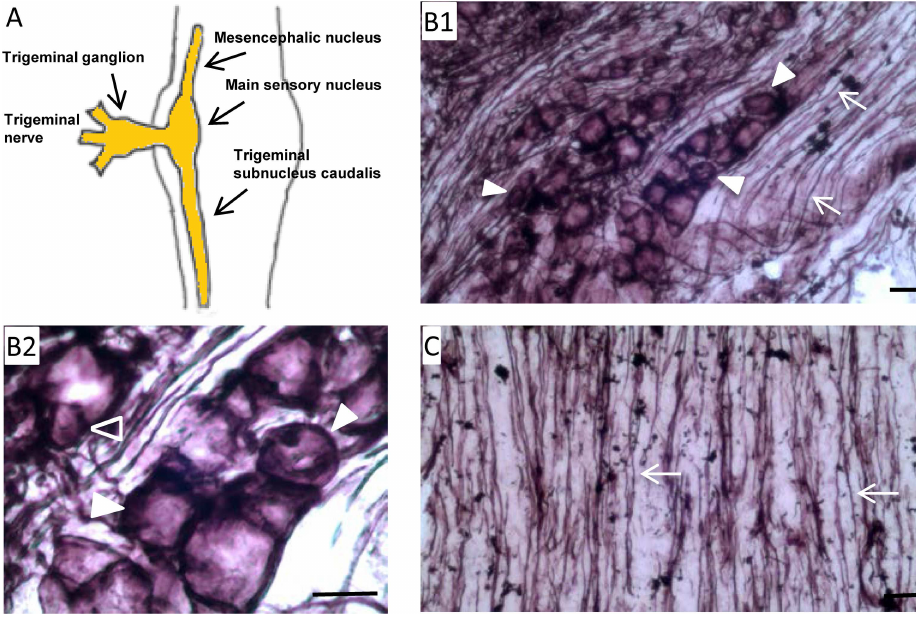
Fig 1. Detection of ecto-ATPase activity in trigeminal nerves. A: Diagram illustrating the trigeminal nerve system. B: Histochemical staining for ecto-ATPase activity in trigeminalganglia. B1: Ecto-ATPase activity is detected in both trigeminal ganglia(TG) neurons (solid triangles) as well as in nerve fibers (arrows); B2: Ecto-ATPase activity is detected in both large (solid triangles) and small (open triangle) TG neurons. C: Histochemical staining for ecto-ATPase activity in trigeminal nerves trunks. Ecto-ATPase activity is detected in trigeminalnerve fibers projectingto the brainstem (arrows). Scale bars: 10 μ m for B1, B2 and C